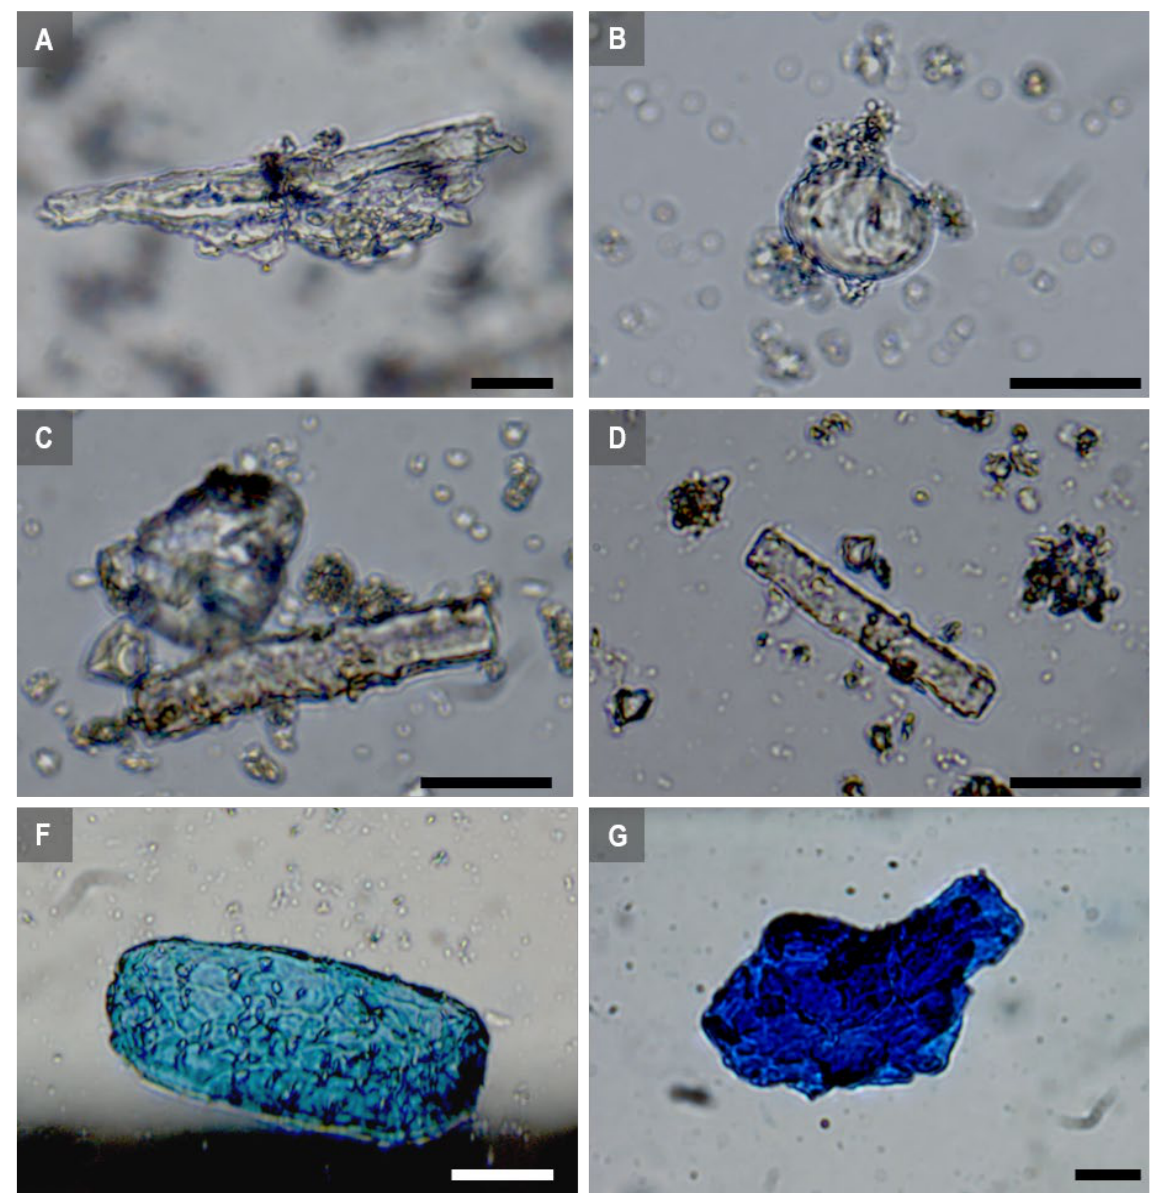
Figure 6: Residues documented on both surfaces of the tool (scale bars are 20 µm). A) amorphous tissue from a groove on Surface 1; B) isolated starch grain from a groove on Surface 2; C) degraded rod-shaped phytolith from a groove on Surface 1; D) Generic, rod-shaped phytolith from a groove on Surface. E-F) Plant tissues from grooves on Surface 2 stained with Methylene